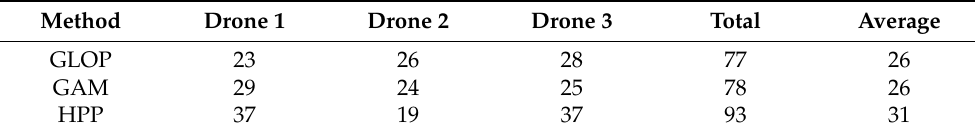
Table 10. Battery Drain